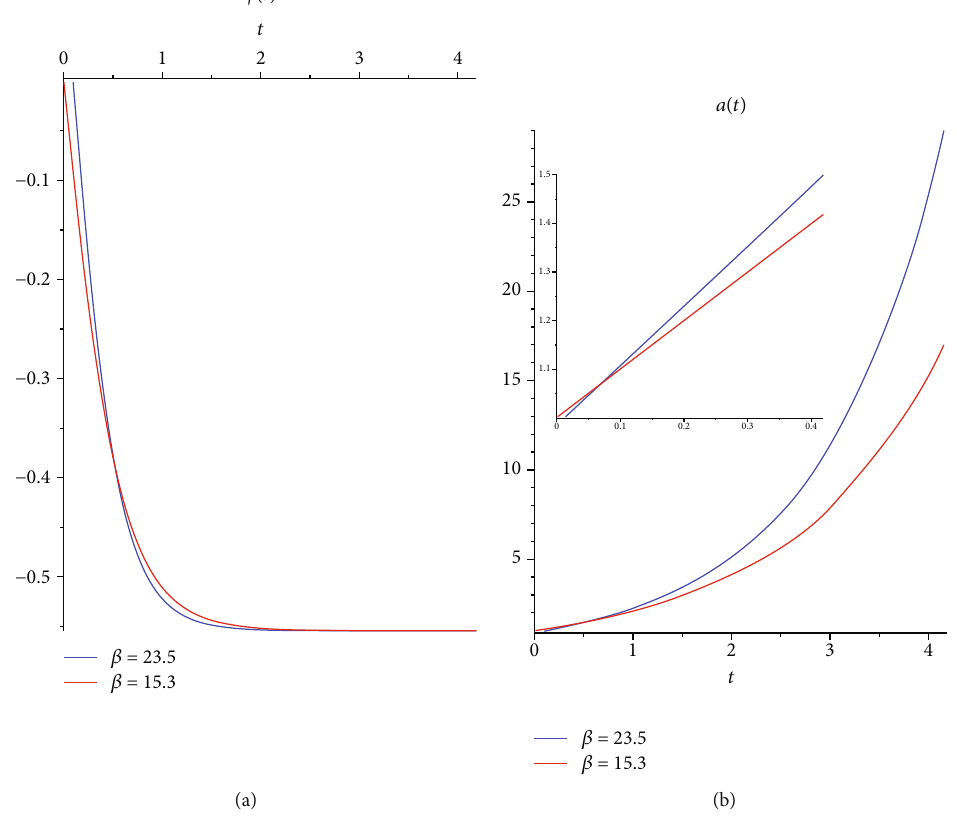
Figure 1: The behavior of the solutions of equation (8): ϕ ð t Þ (a) for β = 23 : 5 , with α = 0 : 06 and η = 0 : 04 (blue curve), and β = 15 : 3 , with α = 0 : 08 and η = 0 : 06 (red curve); a ð t Þ (b) for the same values of parameters. The inset shows the behavior of a ð t Þ at smaller times. Particularly, a ð 0 Þ = 1 , for β = 15 : 3 (red curve), where t = 0 does not mean the Big Bang. Instead, it means the time at which our formalism starts to describe the present phase of the